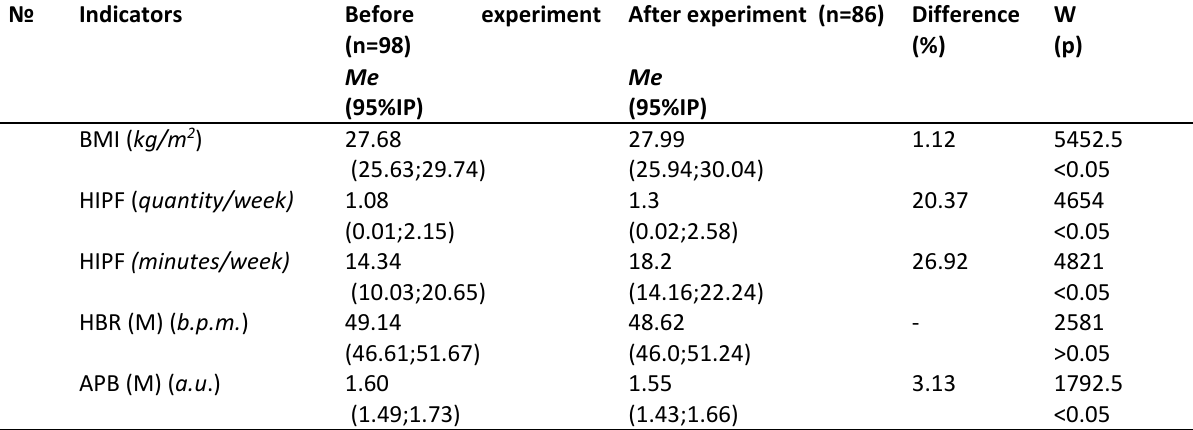
Table 4. Comparison of physical functioning and physical condition indicators in laboratory and forming